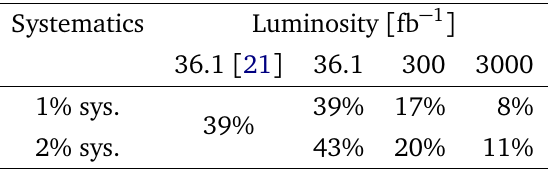
Table 2: 95% CLs limits on the invisible Higgs branching ratio from the leptonic ZH channel. The ATLAS indicated by an asterisk result is taken from Ref. [ 21 ]